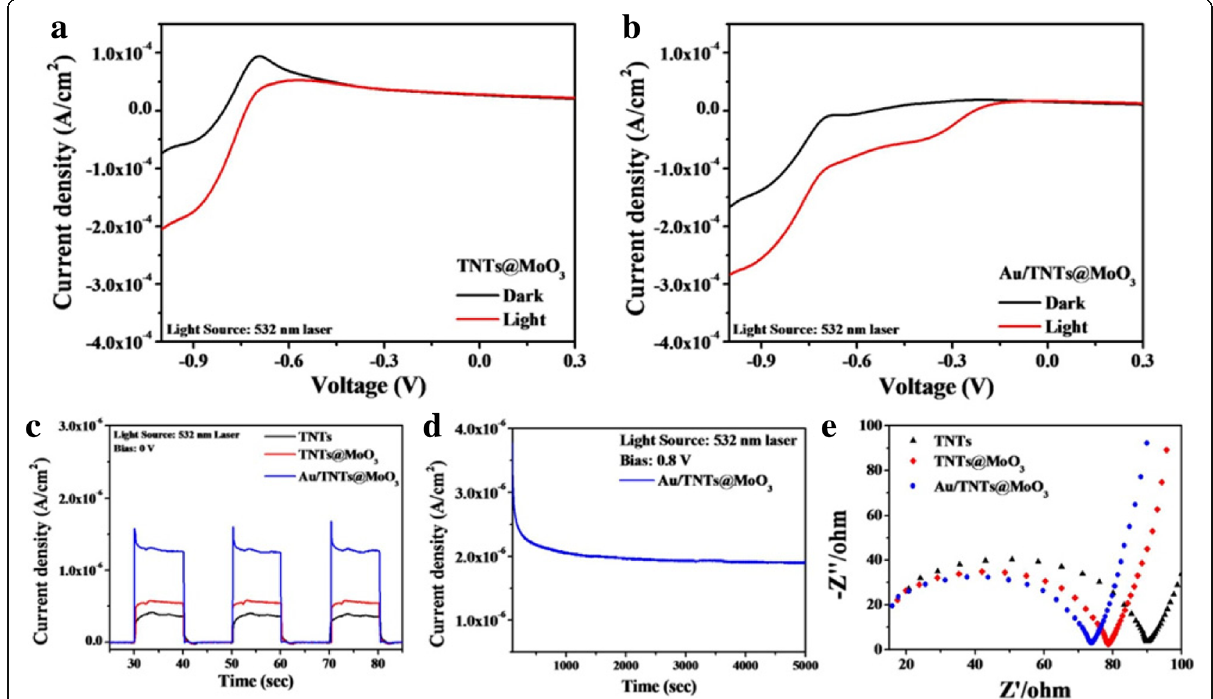
Fig. 3 Linear sweep curves of photoelectrodes a without and b with light irradiation, and photocurrent responses at c 0 V (light source: 532-nm laser). d Prolonged photocurrent measurements under 532-nm laser irradiation. e Nyquist plots of various